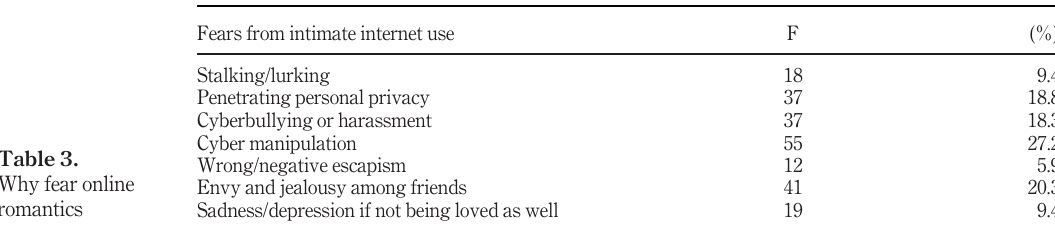
Table 2. How the sample react when they receive a romantic message